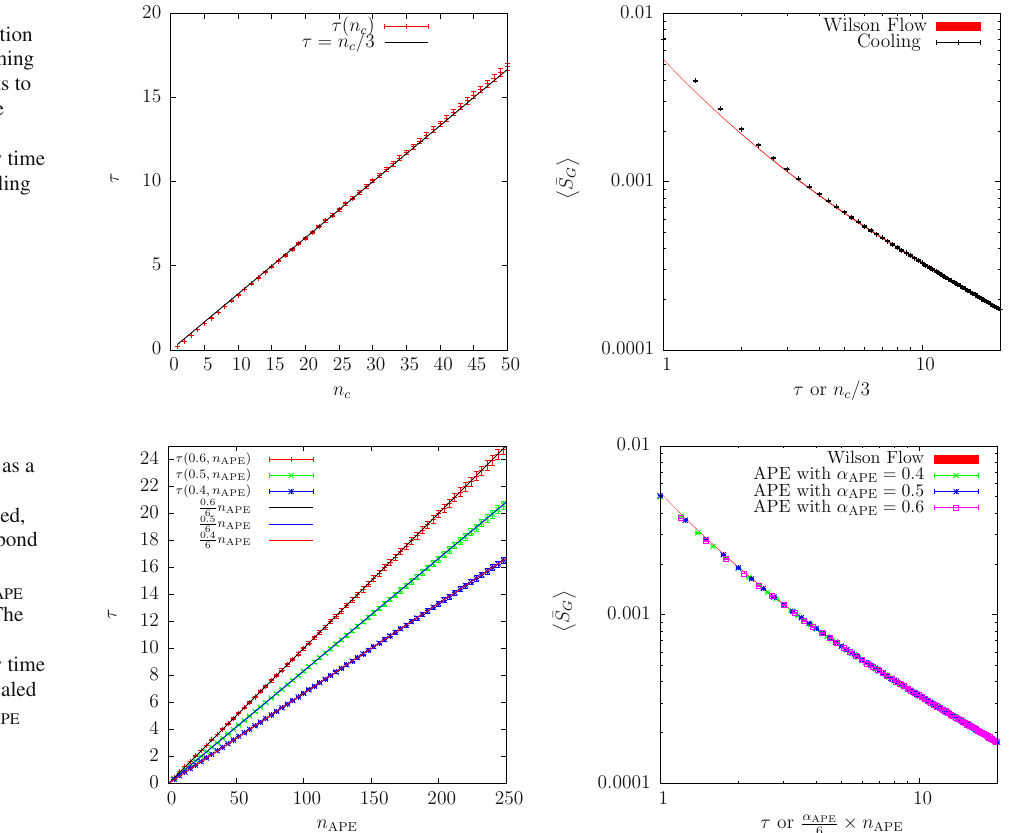
Fig. 1 Left Panel: The behavior of τ( n c ) as a function of n c for the Wilson smoothing action. The line corresponds to τ = n / 3. Right Panel: The c average action density as a function of the Wilson flow time τ or the corresponding cooling step n c / 3